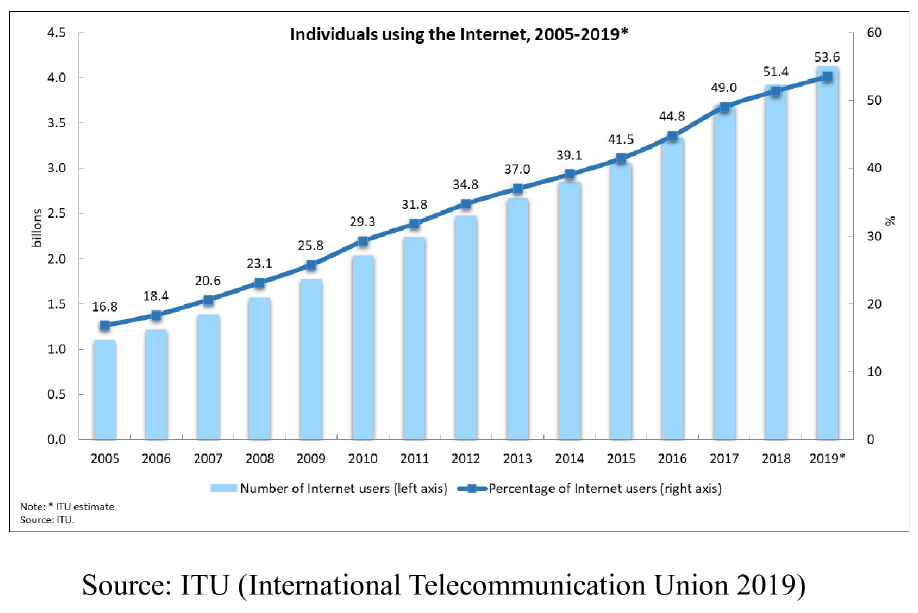
Fig 1. Individuals using the internet from 2005 until